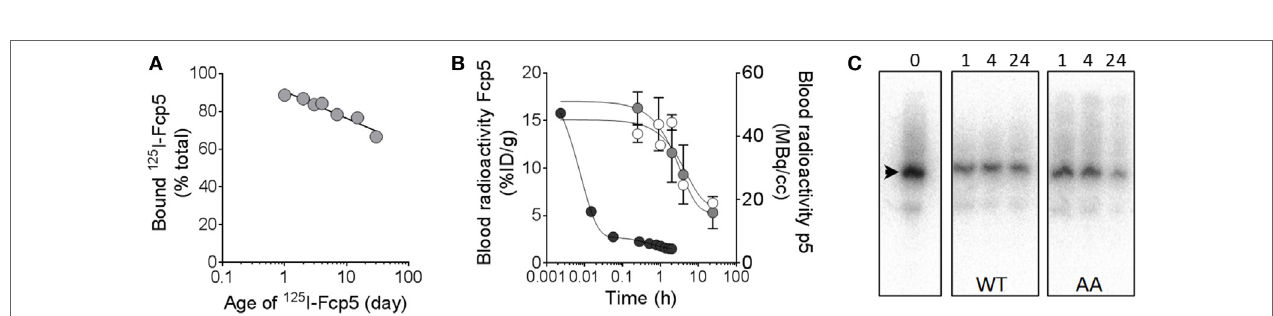
FigUre 6 | Radioiodinated Fcp5 is stable in vitro and in vivo with an extended serum half-life as compared to p5. (a) Binding of a preparation of 125 I-Fcp5 to rV λ 6Wil fibrils was assessed using a pulldown assay for 30 days post labeling. (B) 125 I-Fcp5 in the blood of wild-type (WT) (white) and AA (gray) mice was measured (%ID/g) over 48 h postinjection by gamma counting and compared to historical data for 124 I-p5 in WT mice (black; MBq/cc). (c) Serum stability of 125 I-Fcp5 in AA and WT mice, up to 24 h postinjection, was assessed by SDS-PAGE and phosphorimaging. There was no evidence of low MW radiolabeled metabolites nor a reduction in the MW of the 125 I-Fcp5 (arrowhead).